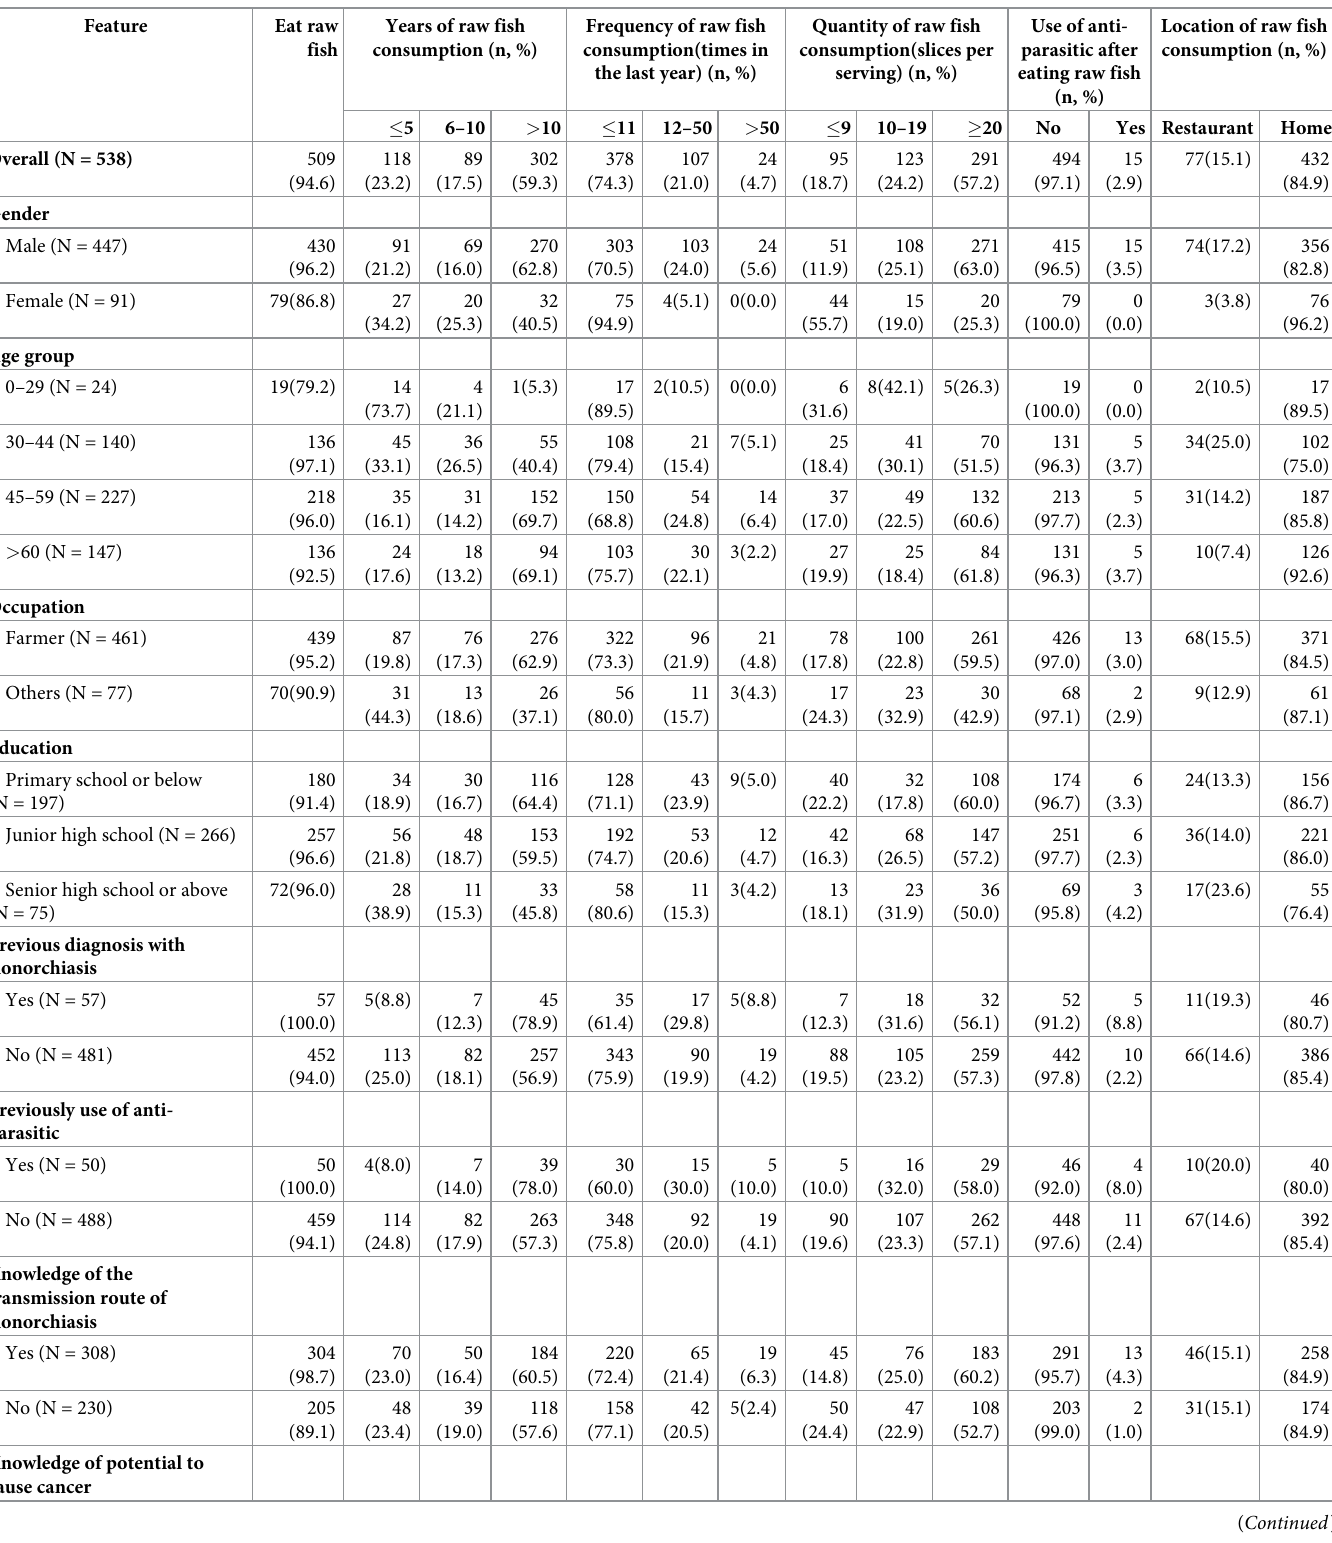
Table 2. Raw Fish Consumption Behaviour of Different Groups of Infected Persons in Binyang County.